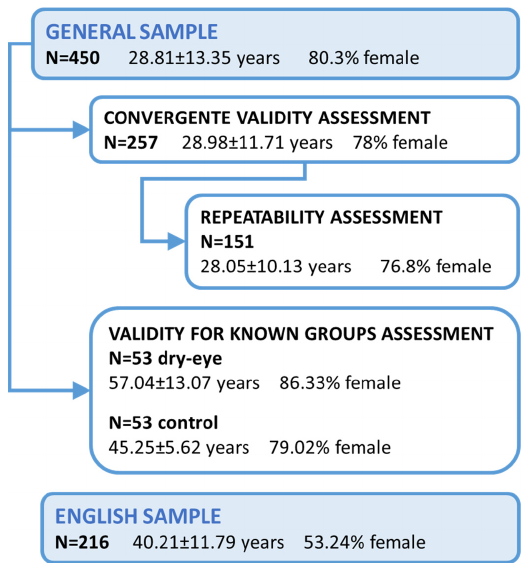
Figure 1. Description of the different samples used in the study.